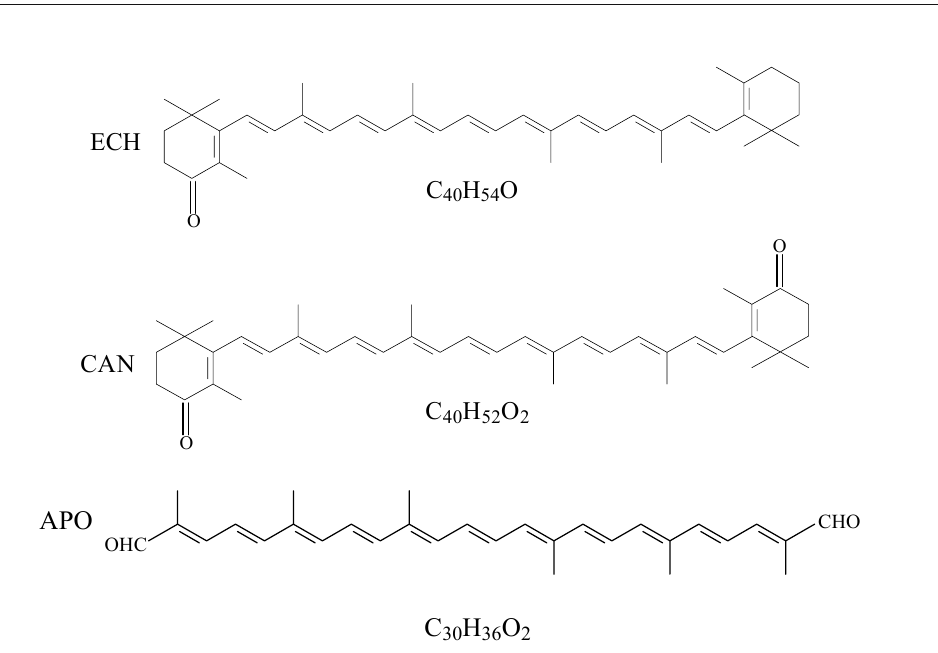
Fig. 1 Molecular structure of carotenoids: β , β -carotene-4-one: ECH, β , β -carotene-4,4’- dione: CAN and 4,4’-diapo- ω , ω -carotene-4,4’-dial: APO. by means of a Hamilton syringe or a micropipette on the air/water interface. The water subphase was a double - distilled water with a resistivity of 18 Mohm cm − 1 . Compression of the monolayer was started after about 10 minutes, allowed for solvent